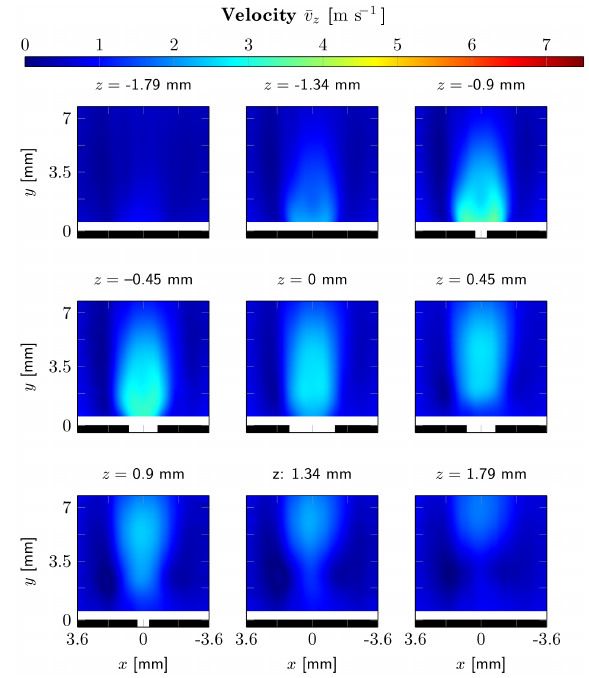
Figure 8. Mean flow velocity ¯ v y in y direction. Figure 9. Mean flow velocity ¯ v z in z